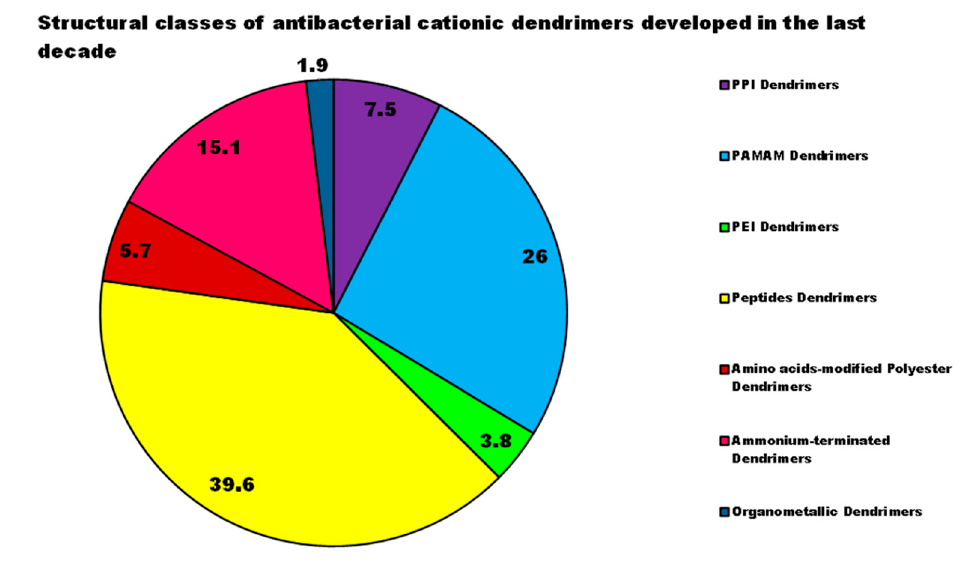
Figure 6. Percentage of the main classes of CADs developed in the years 2010–2020.